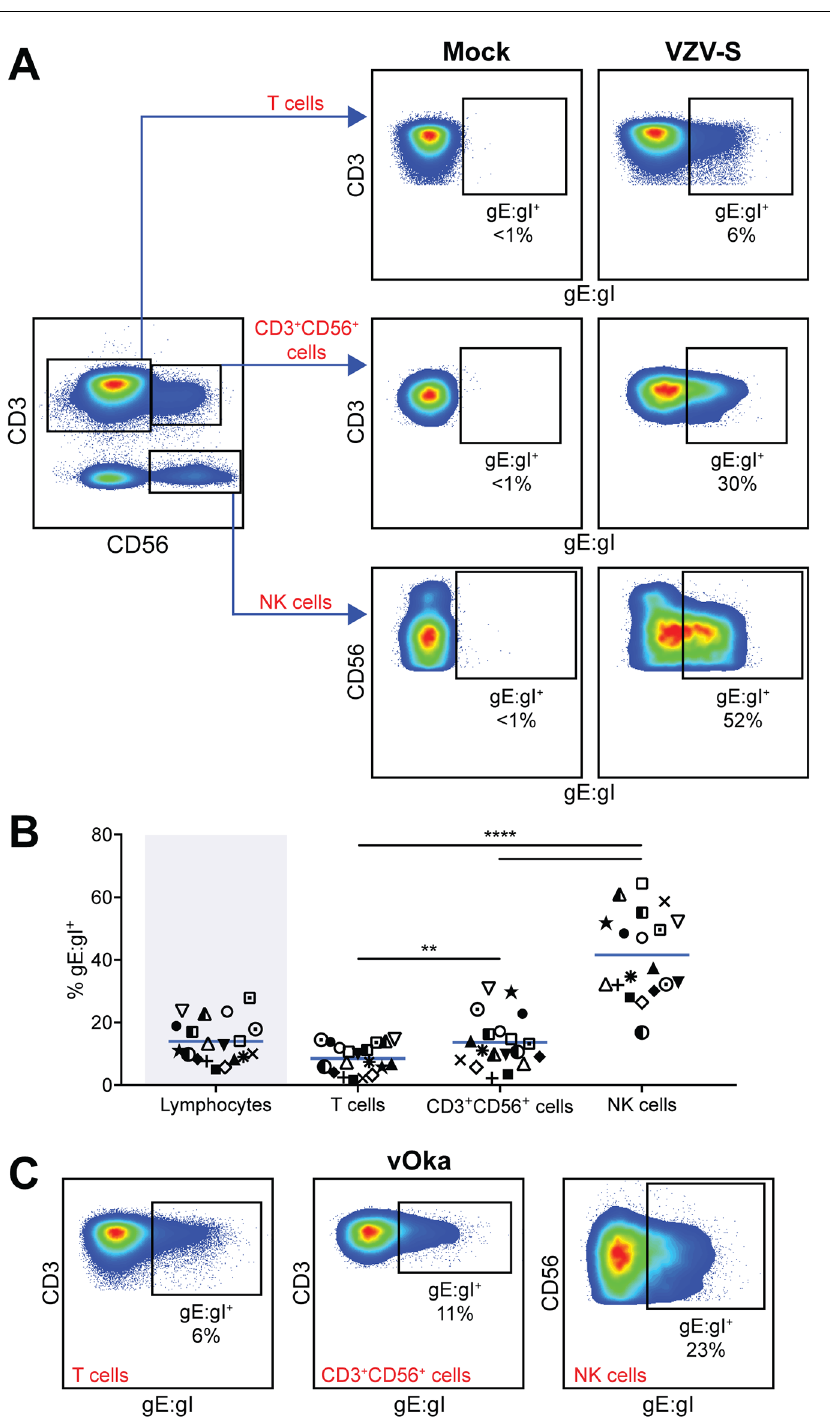
Fig 1. VZV infects human peripheral blood NK cells, CD3 + CD56 + lymphocytes, and T cells. Healthy human donor PBMCs were inoculated with mock or VZV infected ARPE-19 epithelial cells for 2 days then analysed for infection by flow cytometry. (A) Representative flow cytometry plots of mock or VZV-S infection, examining surface VZV gE:gI expression on live T cells (CD3 + CD56 – ), CD3 + CD56 + lymphocytes, and NK cells (CD3 – CD56 + ). (B) Frequencies of live gE:gI + lymphocytes in total (shaded), compared to specific populations: T cells, CD3 + CD56 + lymphocytes, and NK cells (n = 19). Symbols represent individual donors consistent across lymphocyte populations, and bars indicate mean. Statistical analysis was performed between specific lymphocyte populations. (cid:3)(cid:3) p < 0.01, (cid:3)(cid:3)(cid:3)(cid:3) p < 0.0001 (RM one-way ANOVA with the Greenhouse-Geisser correction and Tukey’s multiple comparisons test). (C) Representative flow cytometry plots of vOka infection, examining surface gE:gI expression on live T cells (CD3 + CD56 – ), CD3 + CD56 + lymphocytes, and NK cells (CD3 – CD56 + ) (n = 3).